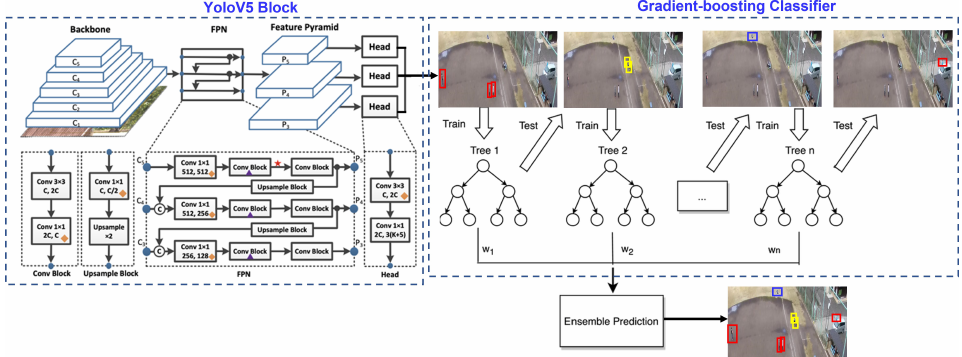
Figure 2. The left side of this figure explains the anchor-box free single-stage YoloV5 detector. YoloV5 architecture comprises of backbone architecture, neck layer as feature pyramid network (FPN), and prediction heads as bottleneck layers. The right side of this figure illustrates gradient boosting, which ensembles the predictions of the Yolo classifier for final action